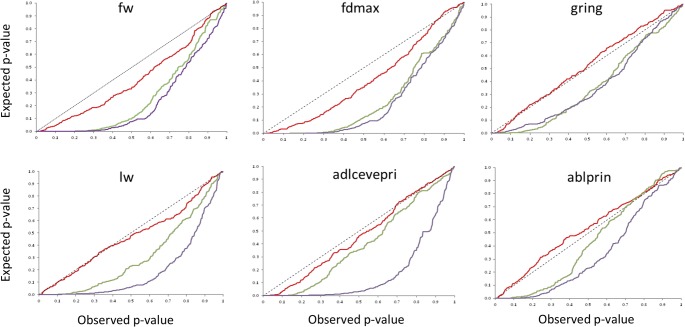
Cumulative density functions based on the three alternative GWA models.The GLM Naive (violet trace), GLM Q-model (green trace) and MLM (red trace). Traits showing significant associations and providing the most consistent p-values are indicated.